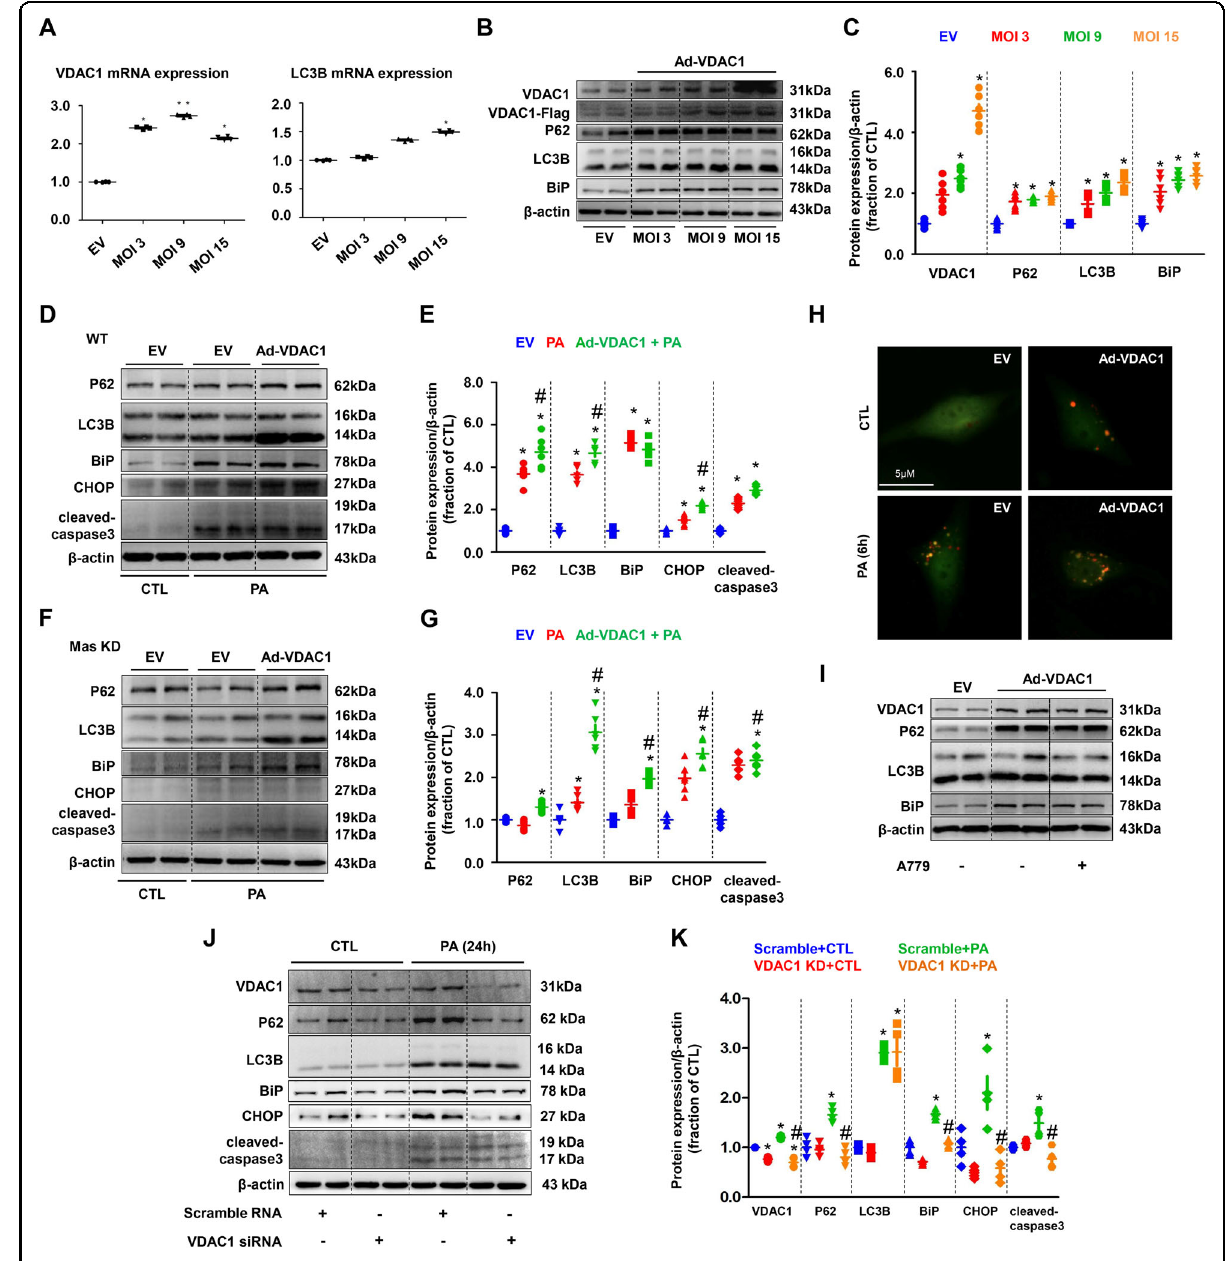
Fig. 8 VDAC1 was involved in PA-induced impaired autophagy, ER stress and cell death in HK2 cells. A mRNA levels of VDAC1 and LC3B were examined by quantitative RT-PCR in empty vector (EV) and adenovirus encoding VDAC1 (Ad-VDAC1) transfected HK2 cells. B and C Representative immunoblots and corresponding densitometry analysis of VDAC1, P62, LC3B, and BiP protein abundance in HK2 cells transfected with Ad-VDAC1. β -actin was used as a loading control. D and G Representative immunoblots and corresponding densitometry analysis of protein markers of autophagy, ER stress and apoptosis in PA-treated WT and Mas knockdown (KD) HK2 cells transfected with Ad-VDAC1. β -actin was used as a loading control. H Confocal microscopy images of LC3B puncta formation in Ad-VDAC1 transfected HK2 cells treated with PA (400 μ M) for 6 h. I Representative immunoblots and corresponding densitometry analysis of VDAC1, P62, LC3B, and BiP protein abundance in EV or Ad-VDAC1 transfected HK2 cells treated with A779. J and K Representative immunoblots and corresponding densitometry analysis of VDAC1, P62, LC3B, BiP, CHOP and cleaved-caspase-3 protein abundance in PA-treated HK2 cells transfected with VDAC1 siRNA. β -actin was used as a loading control. EV, empty vector; Ad, adenovirus. Data are shown as mean ± SEM; * P < 0.05 compared with EV + CTL; # P < 0.05 compared with EV + PA. The experiment was repeated three